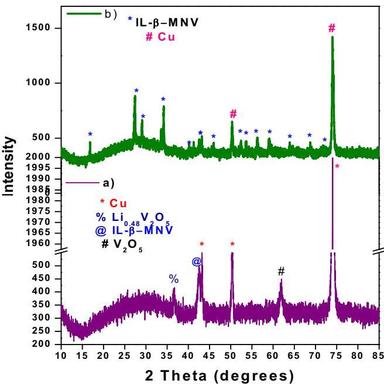
Ex situ XRD patterns of IL-β-MNV after a) lithiation and b) delithiation processes.